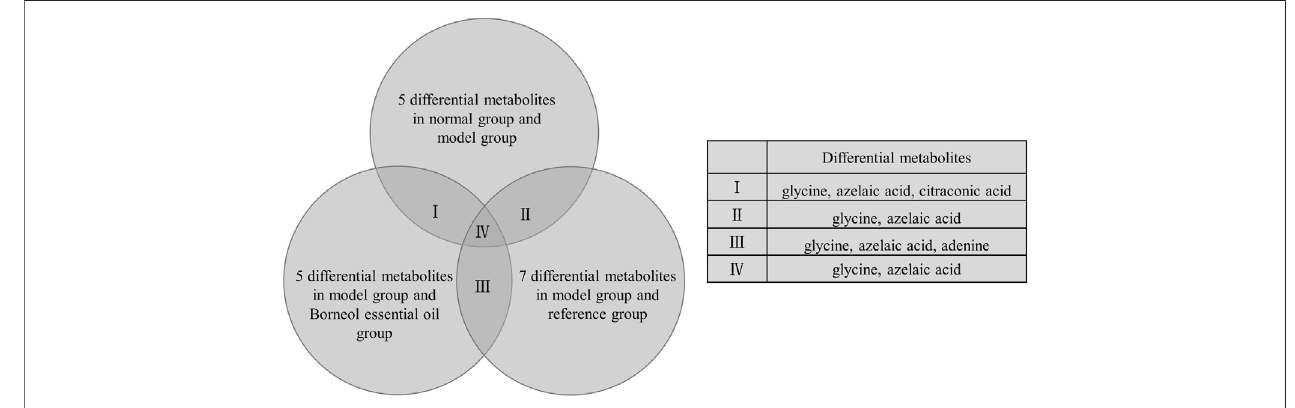
FIGURE 5 | Differential metabolites repeated in plasma samples.